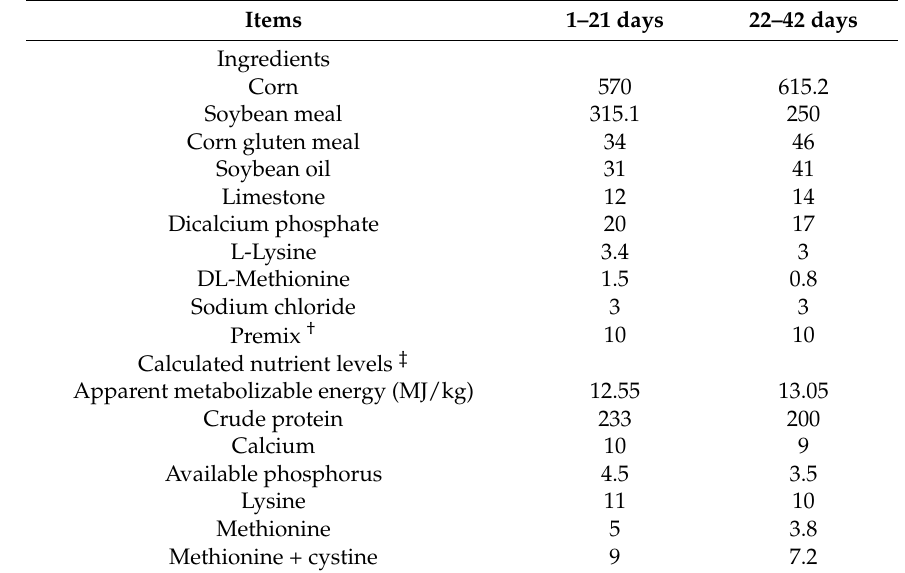
Table 1. Compositions and nutrient levels of the basal diet (g/kg, as fed basis unless otherwise stated).